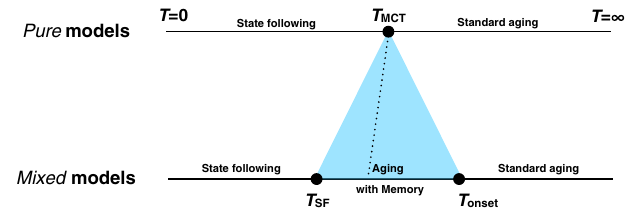
FIG. 9. Schematic phase diagram change when going from pure to mixed p -spin models. In general, the mode-coupling temper- ature T (dashed line) is not a phase MCT